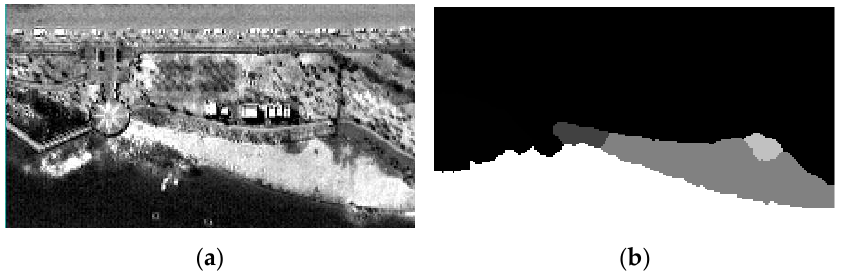
Figure 10. Buoys data set . ( a ) Radiance domain image and ( b ) segmentation map. The results of the method testing are shown in Figure 11.